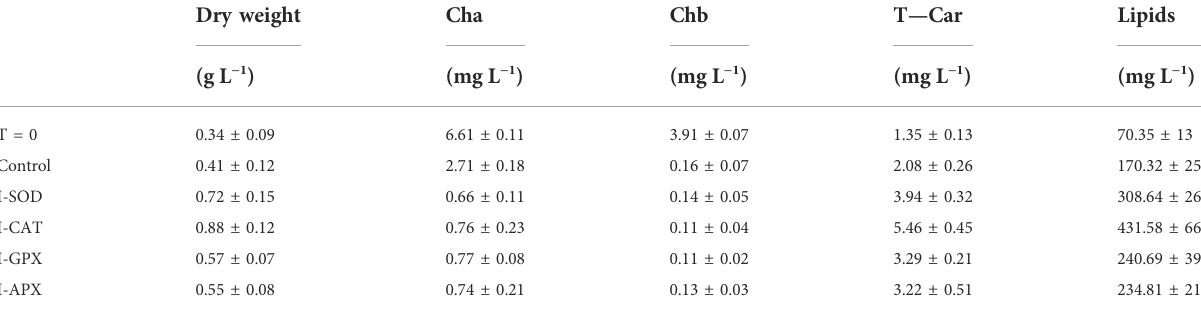
TABLE1Dryweight,cha,chb,T-carandlipidconcentrationsbetweeninoculation(T=0)andTermination(day9)duringthecarotenogenesisprocess for all